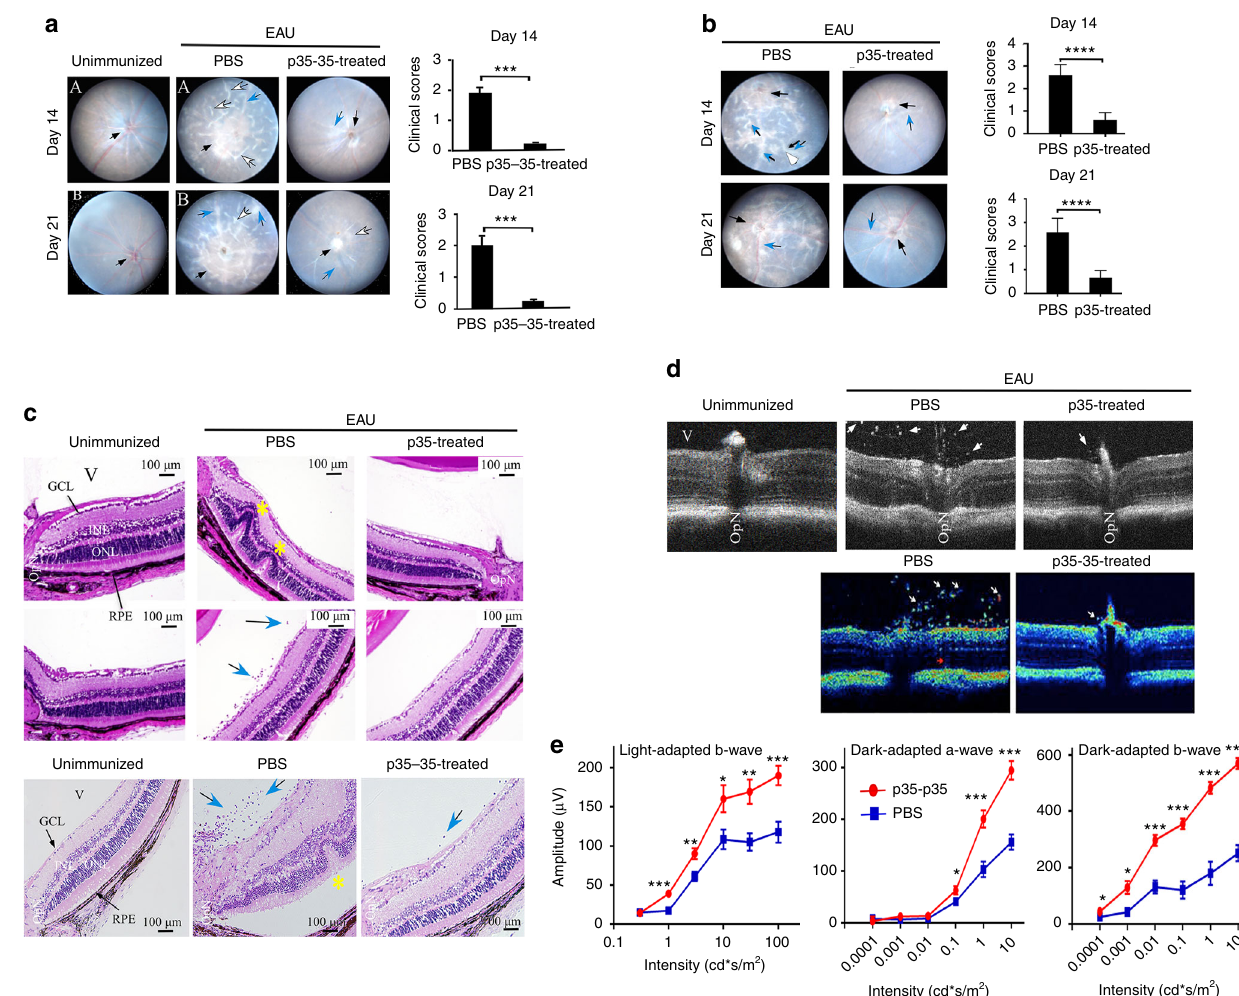
Fig. 3 p35 and p35 − p35 mitigated experimental autoimmune uveitis (EAU). EAU was induced in C57BL/6J mice and some mice were treated with p35 − p35 or p35. Fundus images a , b and histology sections c of the retina at day 14 or day 21 after EAU induction. Fundus images were taken using an otoendoscopic imaging system. Note in fl ammation with blurred optic disc margins and enlarged juxtapapillary area ( black arrows ), retinal vasculitis with moderate cuf fi ng ( blue arrows ), and yellow − whitish retinal and choroidal in fi ltrates ( white arrows ). Clinical scores and assessments of disease severity were based on pathological changes at the optic disc and retinal and choroidal tissues. H&E histological sections c show in fl ammatory cells in retina and vitreous ( blue arrows ) and numerous retinal folds, a hallmark of severe retinitis yellow highlight . OPN, optic nerve; GCL, ganglion cell layer; INL, inner nuclear layer; ONL, outer nuclear layer; RPE (retinal pigmented epithelial cell layer) and choroid. d Layered structure of the retina was visualized by SD-OCT. Representative OCT images taken on day 18 after disease induction show markedly increased in fl ammatory cells ( white arrows ) in the vitreous, retina and posterior chamber of the untreated mice compared to those treated with p35 or p35 − p35. Retinal layer destructions ( red arrow ). e ERG analysis of the retina on day 20 after EAU induction. The averages of light-adapted or dark-adapted ERG b-wave amplitudes are plotted as a function of fl ash luminance and values are mean ± SEM from four animals in each group. Results represent at least three independent experiments and were analyzed using Student ’ s t -test (two-tailed). (* P < 0.05; ** P < 0.01; *** P < 0.001; **** P <